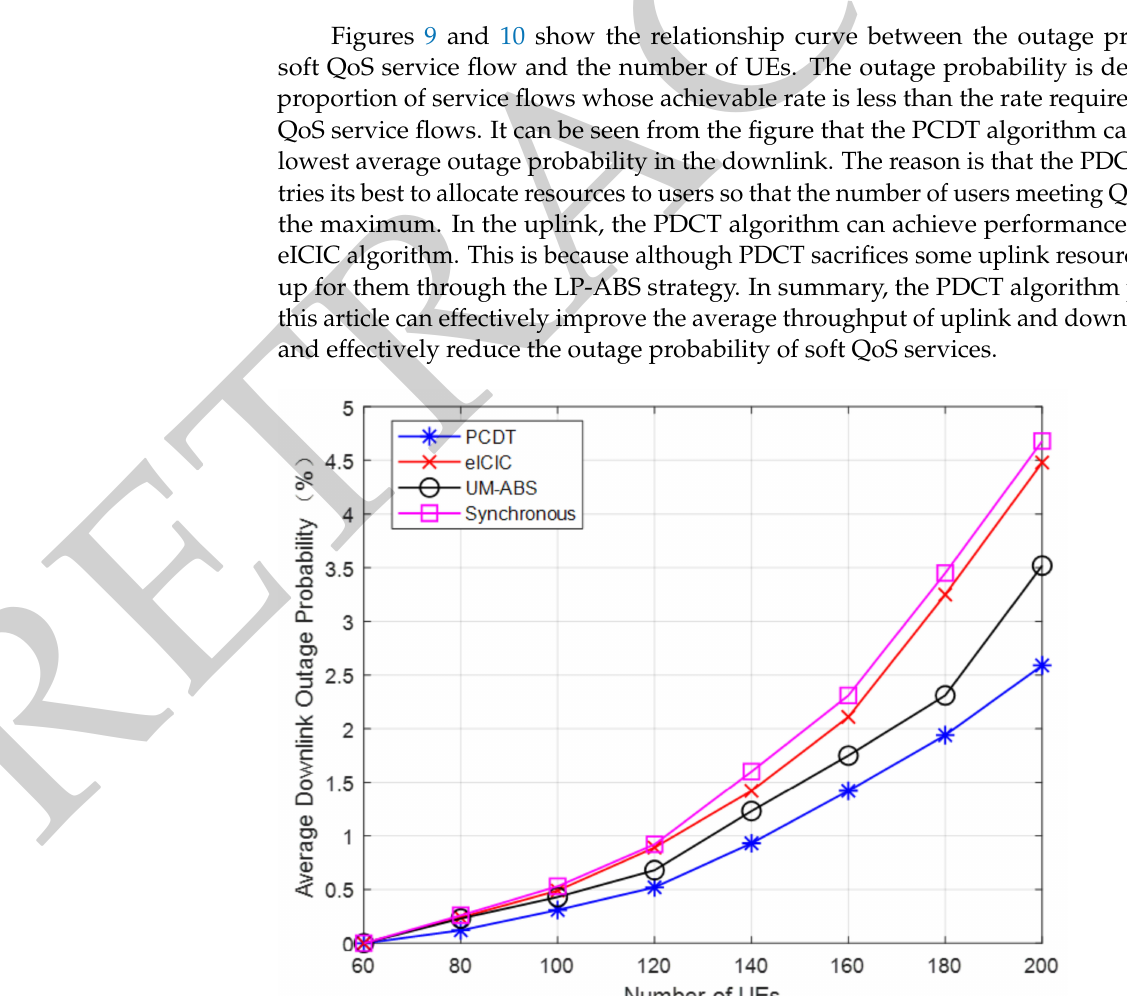
Figure 8. The comparison on the average uplink throughput.